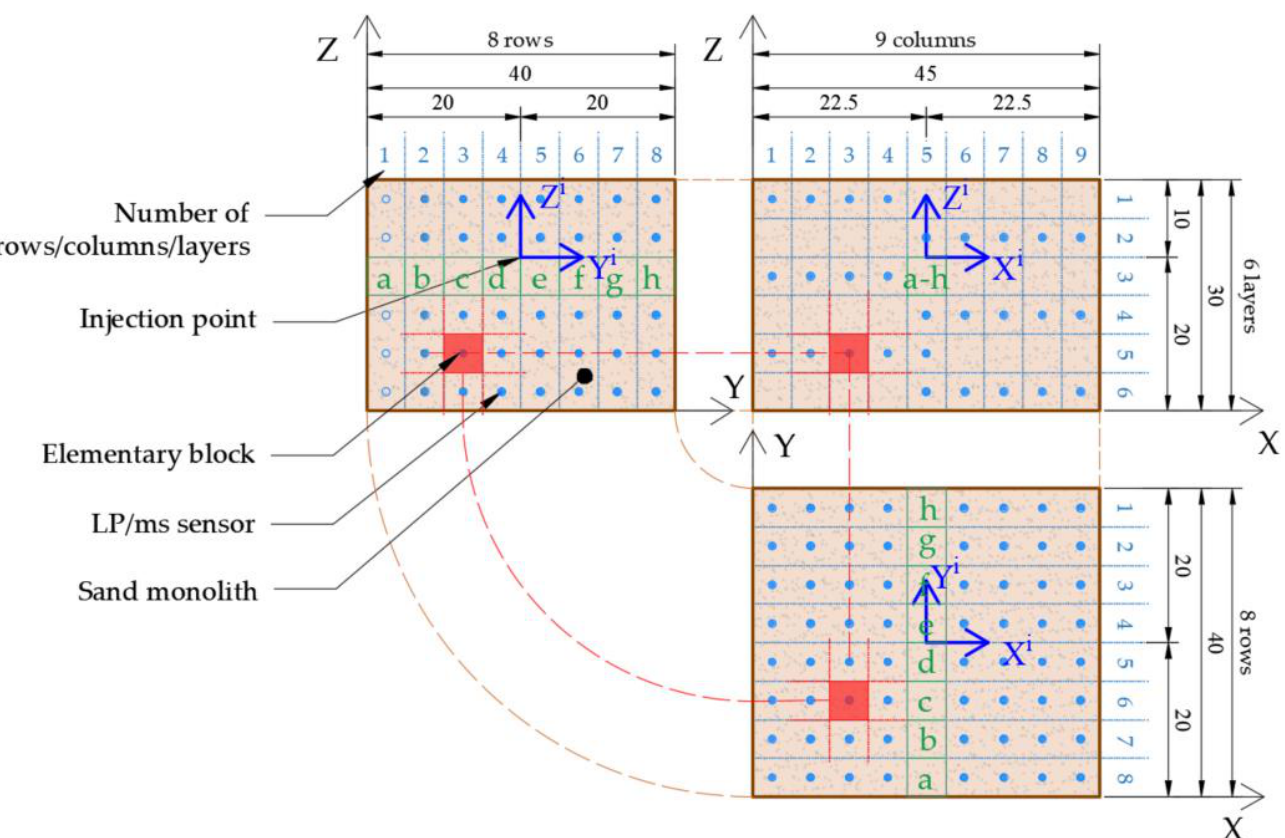
Figure 4. Schematic of the sensor distribution within the physical model and the division of the sand monolith into columns, rows, and layers. Dimensions in centimetres.